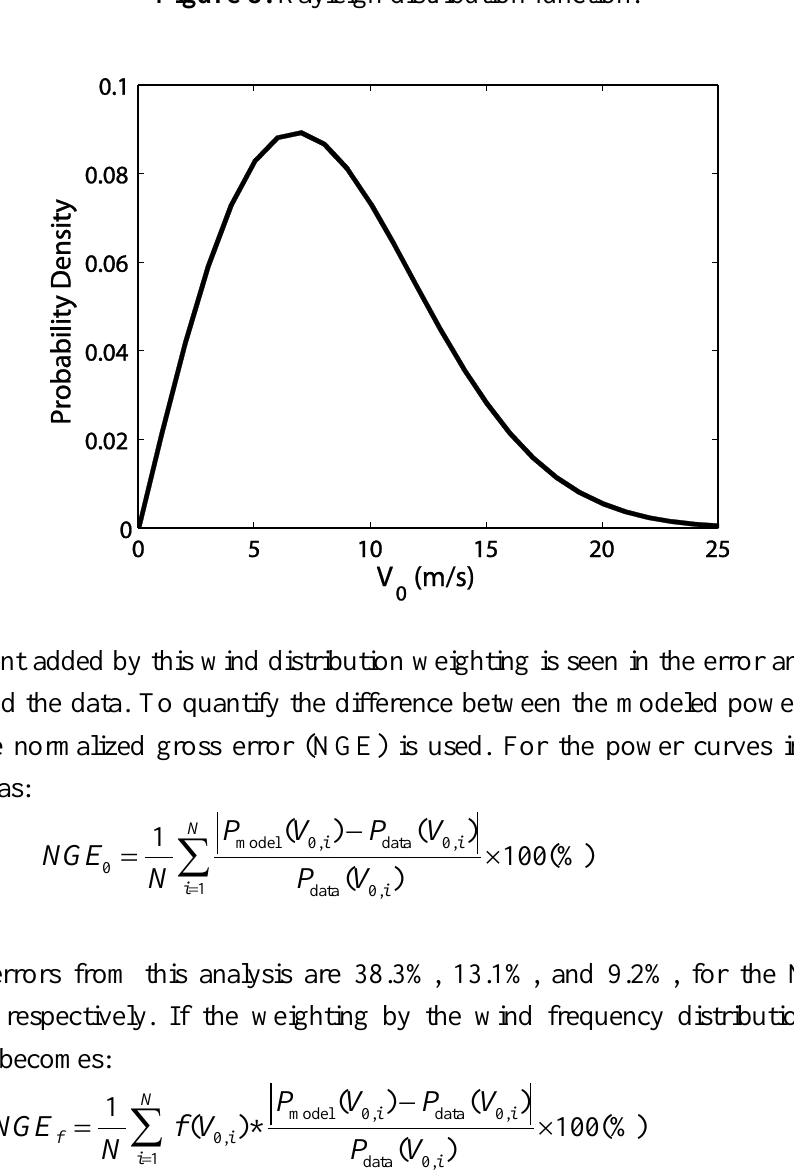
Figure 5. Rayleigh distribution